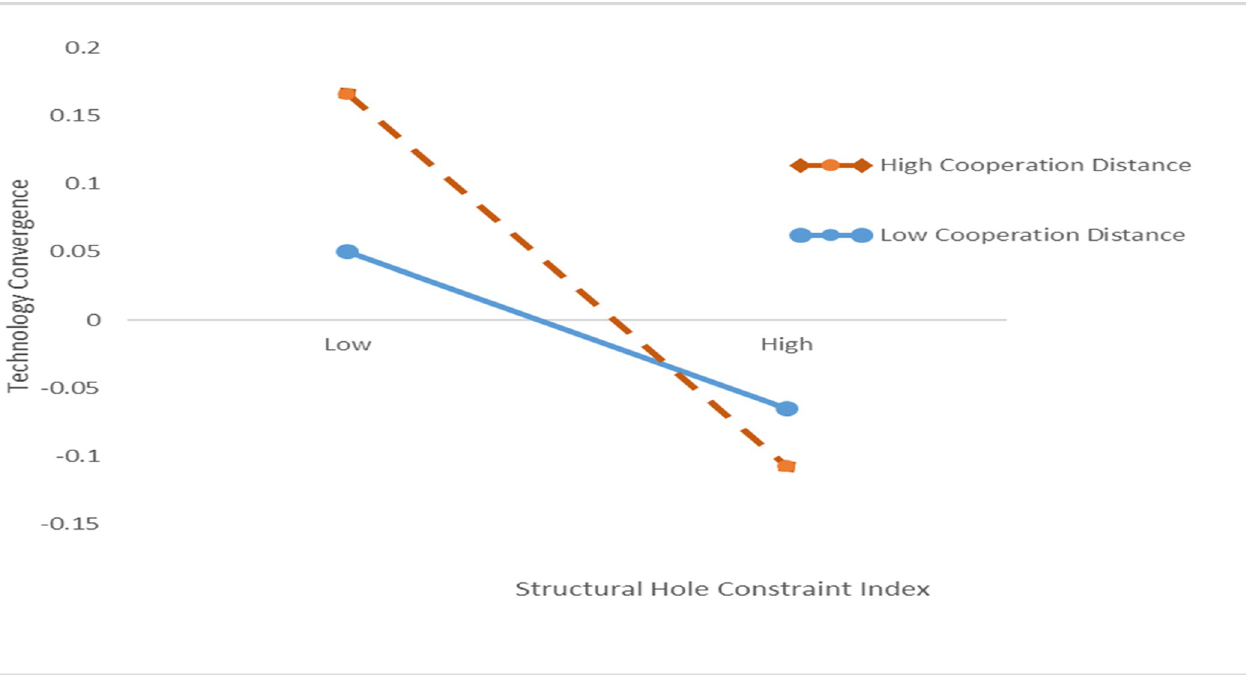
Fig 10. The moderating effect of distance of patent cooperation network for this study.